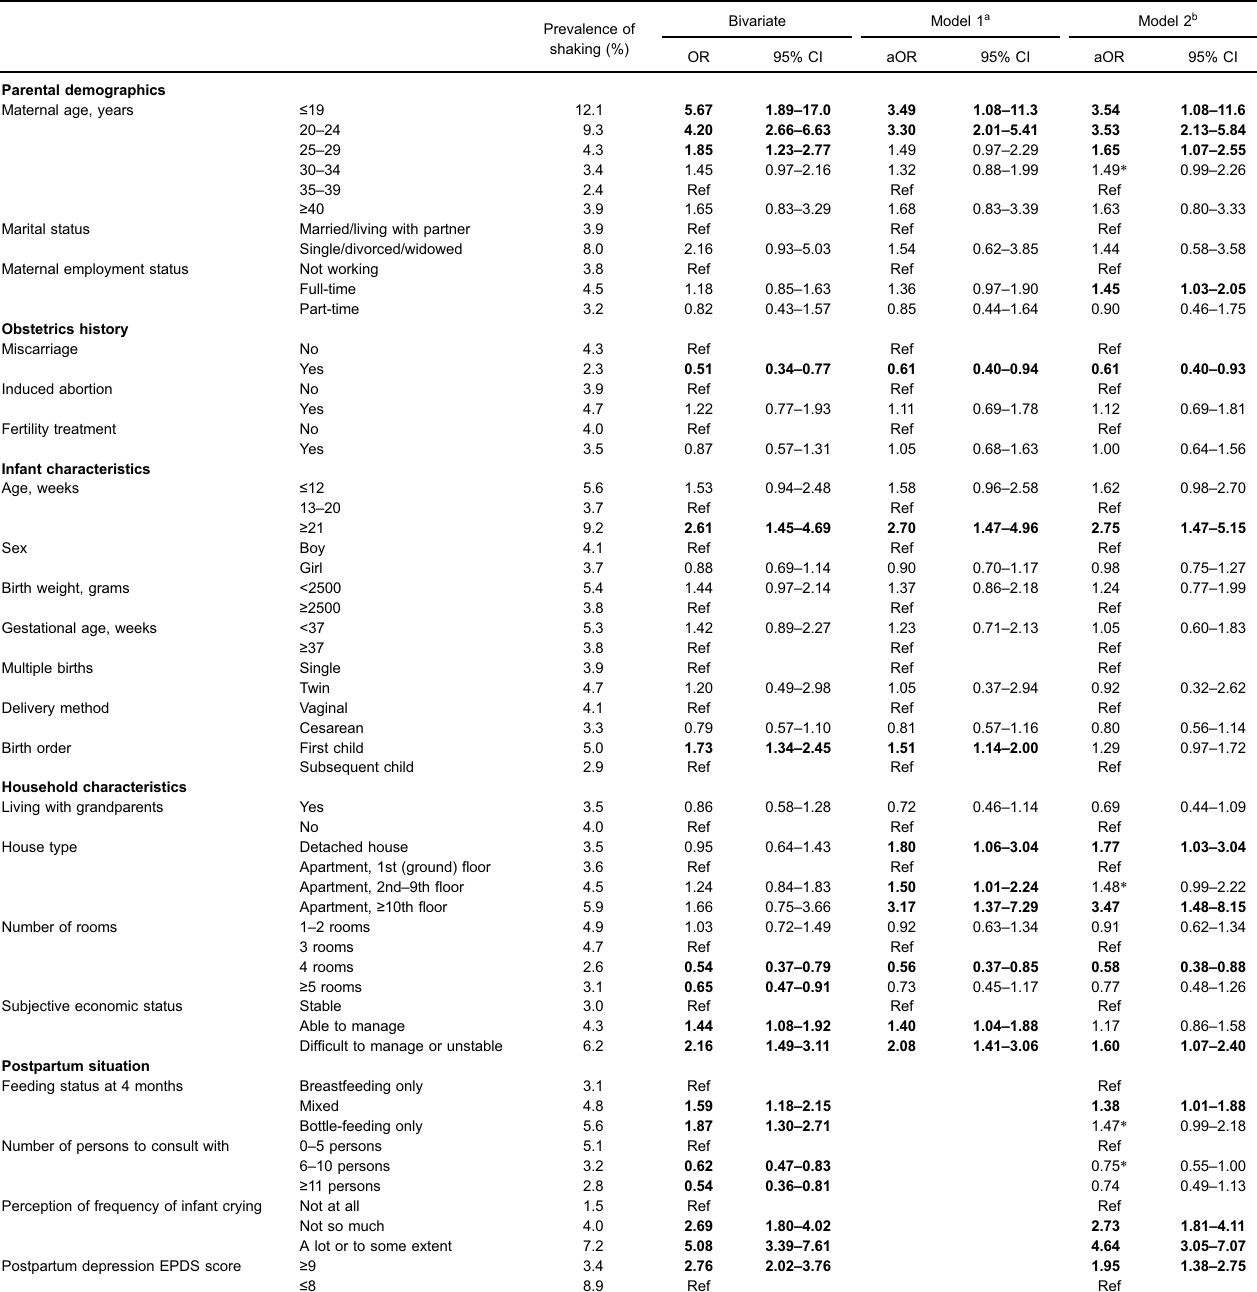
Table 3. Odds ratios of parental demographics, obstetrics history, infant characteristics, household characteristics, and postpartum situation for shaking at 4 months of